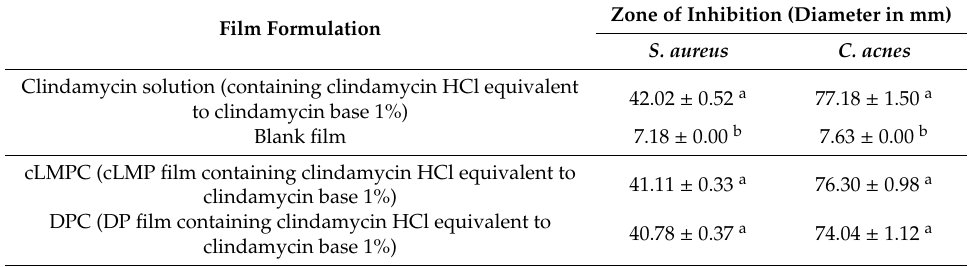
Table 6. The antibacterial activity of pectin films containing clindamycin HCl against Staphylococcus aureus and Cutibacterium acnes.